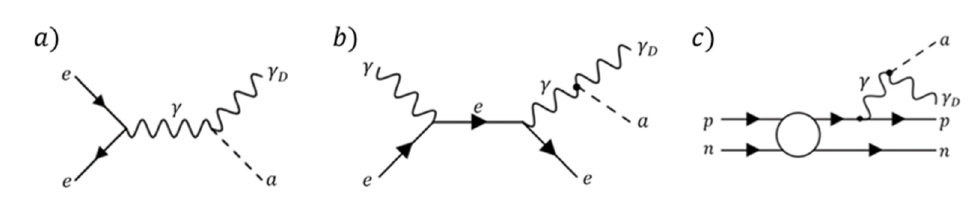
Figure 1 . Representative figures for the 3 leading collision processes that produce axions and dark photons in a supernova. a) e + e − → γ D a , the annihilation of an electron and positron. b) e + γ → e + γ D a , Compton scattering where the off-shell Standard Model photon decays to an axion and dark photon. c) pn → pnγ D a , nuclear bremsstrahlung where the off-shell photon decays to an axion and dark